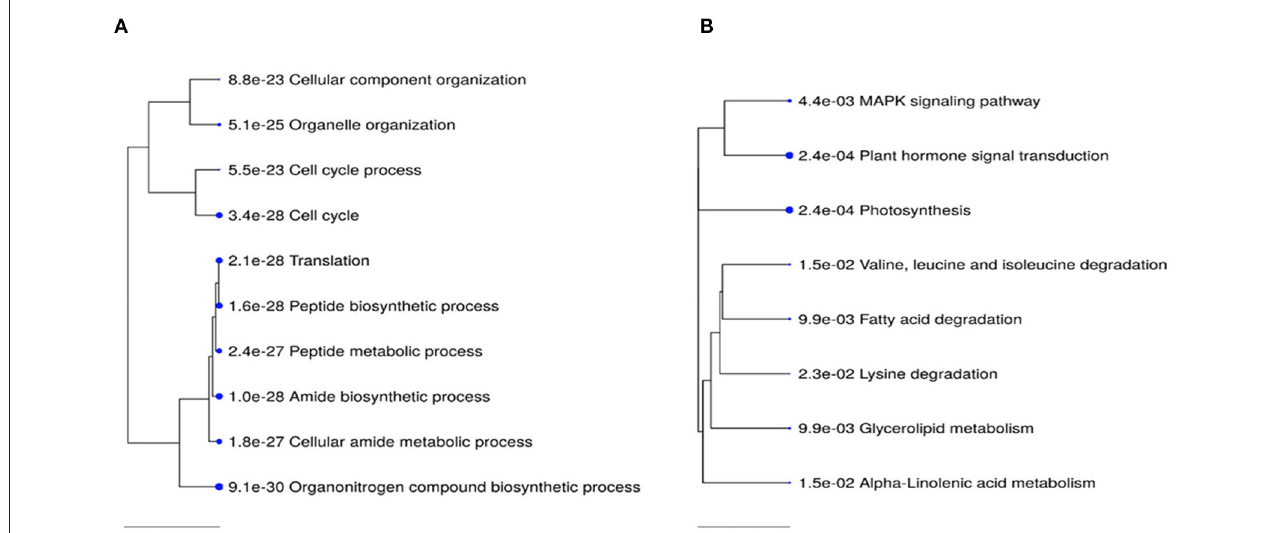
FIGURE 6 | Top 10 KEGG pathway enrichment terms for 2,448 upregulated (A) and 2,952 down-regulated (B) genes in PGR-treated vs. control comparison. Categories of differentially expressed genes that were significantly enriched relative to the Arabidopsis genome ( P -values for the lack of enrichment are shown). PGR, plant growth